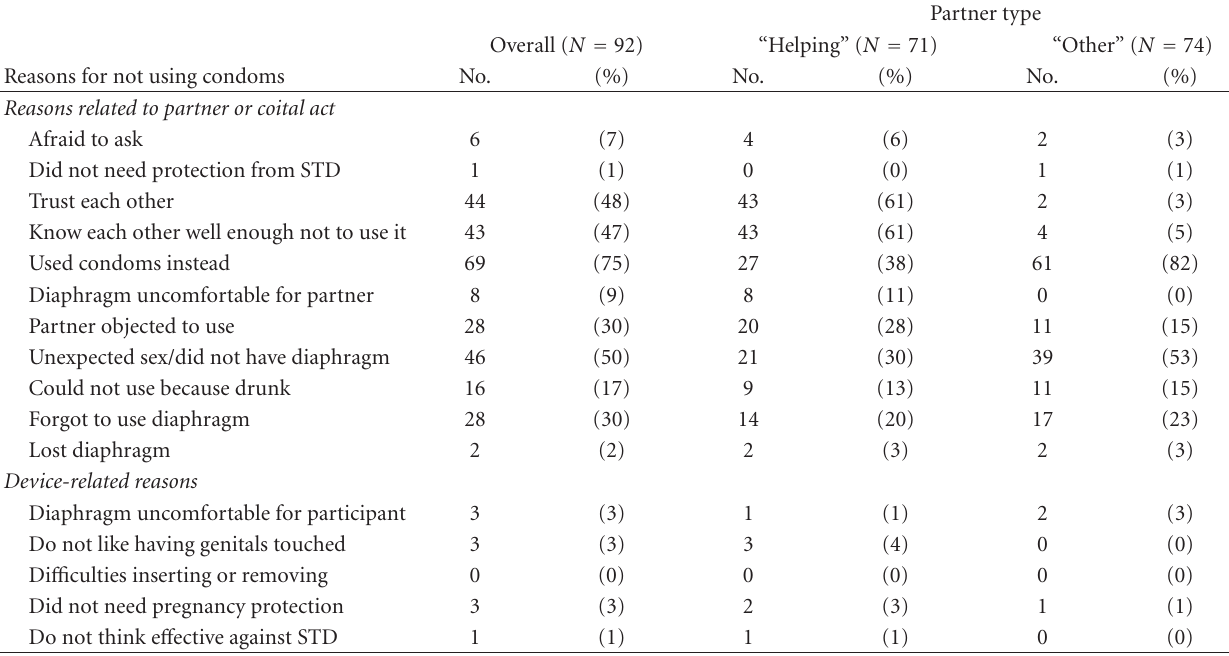
Table 6: Reasons cited for not using diaphragm in previous 2 weeks, overall and by partner type, Nairobi, Kenya, 2004-2005 ∗ . Partner type Overall ( N = 92) “Helping” ( N =